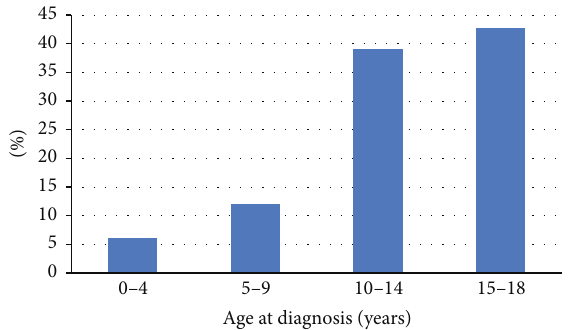
Figure 2: The age distribution pattern at the time of CD diagnosis.